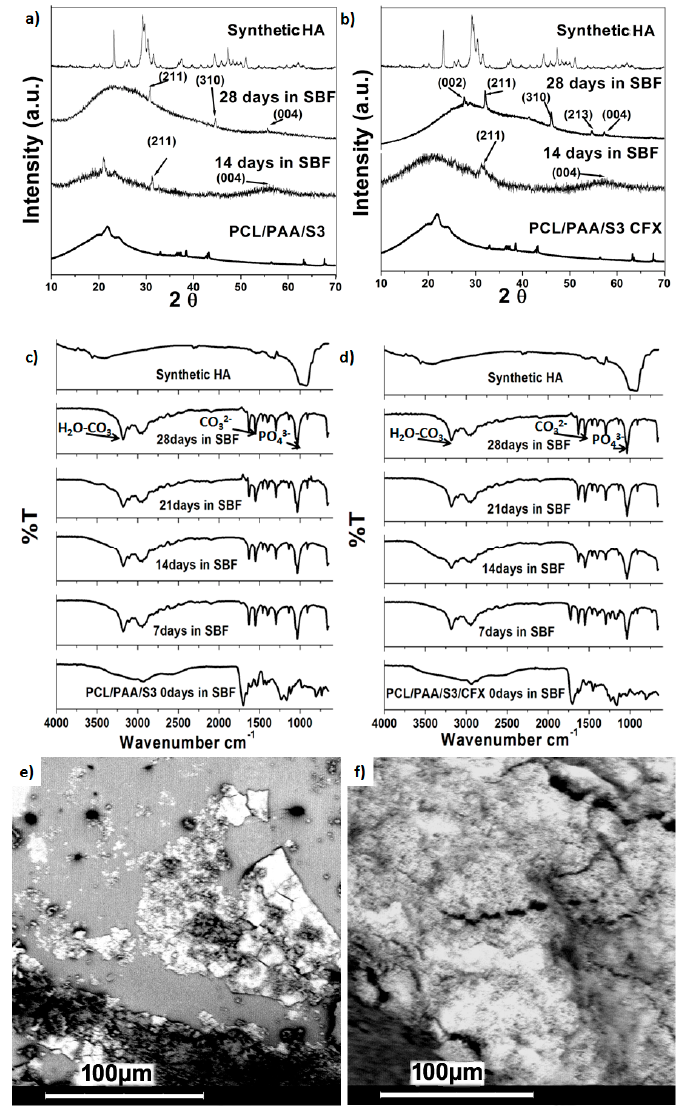
Figure 5. XRD patterns before and after immersion in SBF of ( a ) PCL/PAA/S3 blend and ( b ) PCL/PAA/S3/CFX blend; FTIR spectra before and after immersion in SBF of ( c ) PCL/PAA/S3 blend and ( d ) PCL/PAA/S3/CFX blend; SEM images before and after immersion in SBF of ( e ) PCL/PAA/S3 blend and ( f ) PCL/PAA/S3/CFX blend.